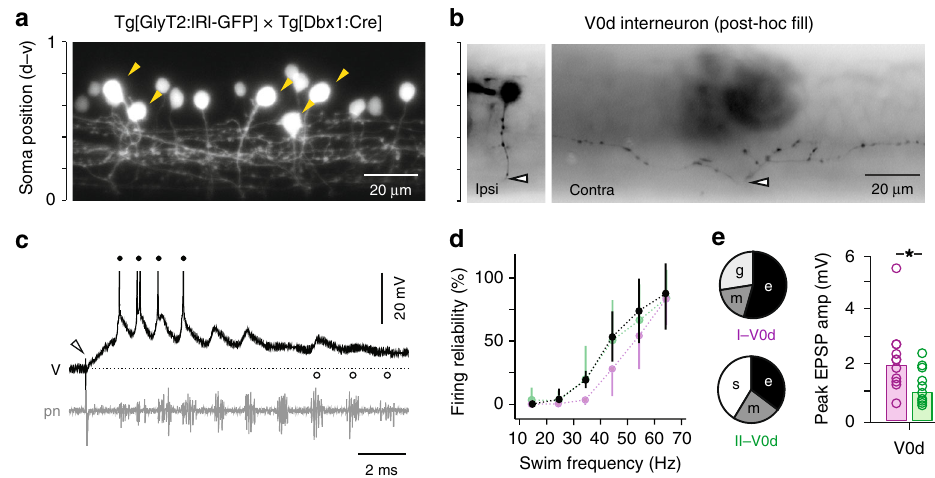
Fig. 5 V0d inhibitory interneuron recruitment and targeting by V2a types. a Single confocal optical section from one spinal segment in compound transgenic larvae illustrating the location of V0ds targeted for recordings (yellow arrowheads). Note, only GFP fl uorescence is illustrated. Scale to the left indicates normalized dorso-ventral soma position. b Contrast inverted epi fl uorescent images after recording illustrating the ipsilateral soma (ipsi) and contralateral axon (contra). The axon crosses at the white arrowheads. Soma position is normalized to dorso-ventral aspects of spinal cord, as in panel a . c Simultaneous current-clamp recordings from a V0d neuron (V) and extracellular recordings of peripheral motor nerves (pn) during fi ctive swimming following a brief electrical stimulus to the skin (open arrowhead). Filled circles highlight suprathreshold swimming frequencies, while open circles highlight examples of subthreshold frequencies. Spikes are truncated to better reveal the underlying synaptic drive. Dashed line indicates resting membrane potential, − 54 mV. d Quanti fi cation of the reliability of fi ring as a function of swimming frequency for V0d neurons ( n = 26). Values are superimposed on V2a data from Fig. 2c. Data are reported as means± standard deviations. Source data are provided in a Source Data fi le. e Left, quanti fi cation of the mode of V2a synaptic connectivity to V0d neurons expressed as a percentage of total responses (I to V0d, n = 11; II to V0d, n = 17). e electric, m mixed, g glutamatergic, s slow. Right, quanti fi cation of the peak amplitudes of fast EPSPs (electric, mixed, or glutamatergic) measured from type I V2a to V0d neurons (purple, n = 11) and type II V2a to V0d neurons (green, n = 10). * signi fi cant difference following Mann – Whitney U -test, U(19) = 84, p < 0.05. Bars represent means. Source data are provided in a Source Data fi le